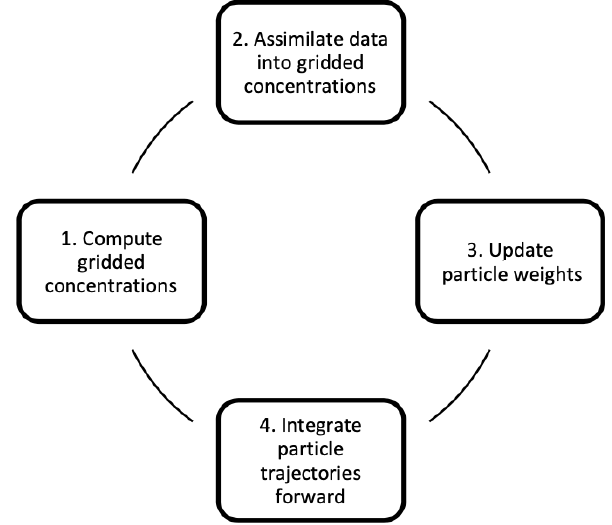
Figure 1. Schematic depiction of the four steps of our